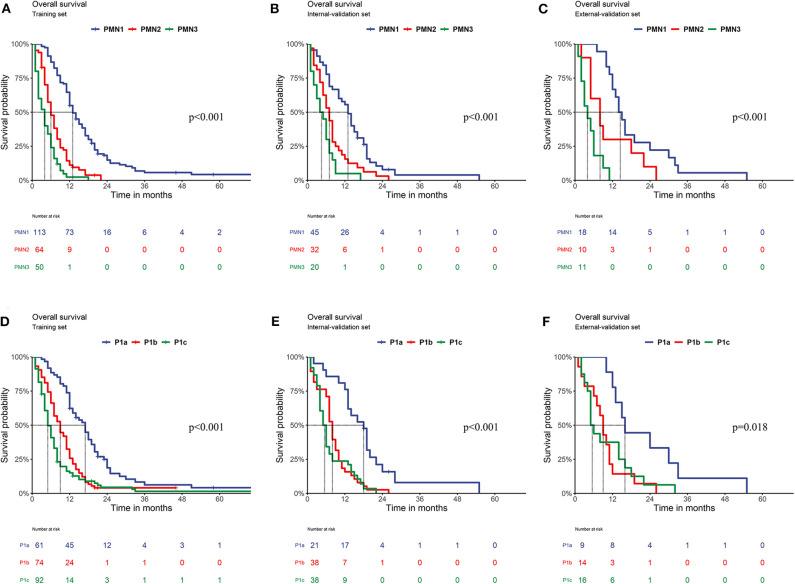
Comparison of OS. (A) Training set of the PMN (PPMN1vs.PMN2 < 0.001; PPMN1vs.PMN3 < 0.001; PPMN2vs.PMN3 < 0.001); (B) Internal validation set of the PMN (PPMN1vs.PMN2 = 0.001; PPMN1vs.PMN3 < 0.001; PPMN2vs.PMN3 = 0.041); (C) External validation set of the PMN (PPMN1vs.PMN2 = 0.039; PPMN1vs.PMN3 < 0.001; PPMN2vs.PMN3 = 0.036); (D) Training set of the P1abc (PP1avs.P1b < 0.001; PP1avs.P1c = P < 0.001; PP1bvs.P1c = 0.022); (E) Internal validation set of the P1abc (PP1avs.P1b < 0.001; PP1avs.P1c < 0.001; PP1bvs.P1c = 0.331). (F) External validation set of the P1abc (PP1avs.P1b = 0.004; PP1avs.P1c =0.022; PP1bvs.P1c = 0.824).